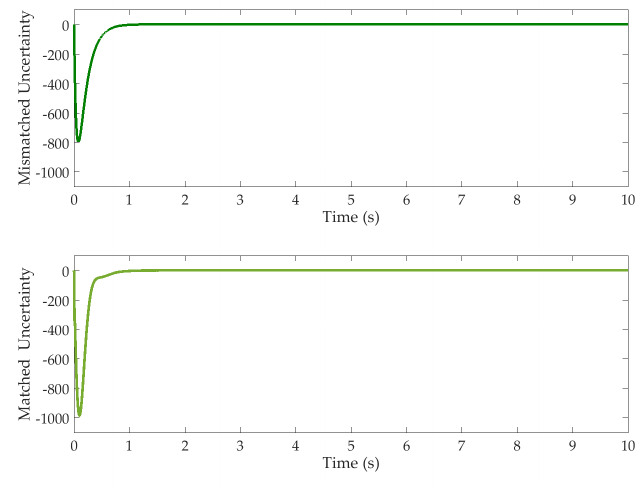
Figure 16. Time response of the